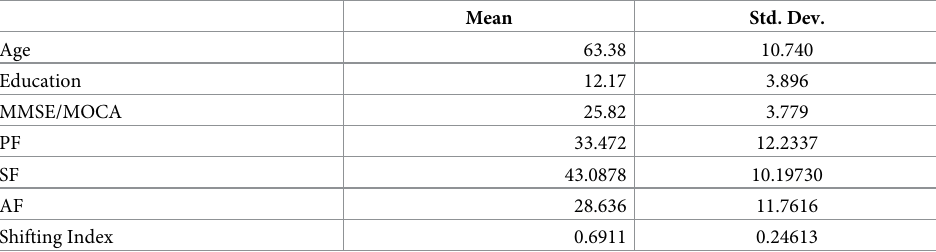
Table 1. Demographic characteristics and test